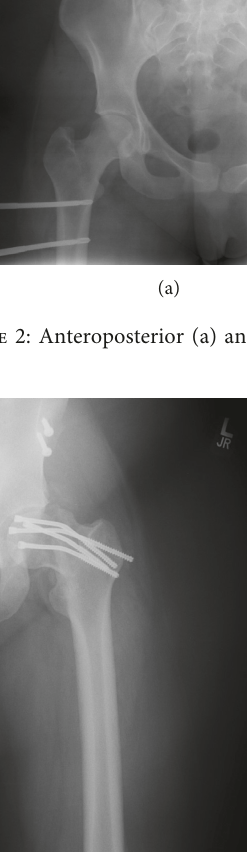
Figure 3: Anteroposterior radiograph showing bending of screws and hardware